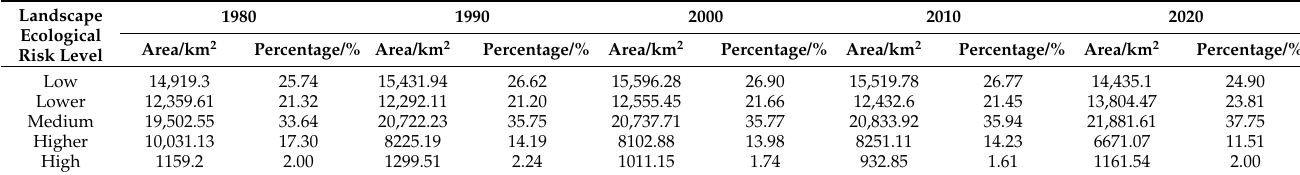
Table 4. Distribution of landscape ecological risk areas from 1980 to